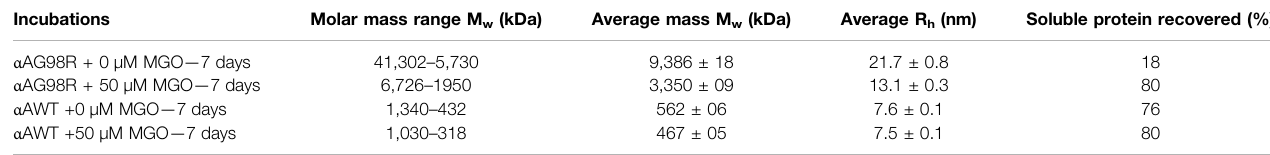
TABLE 2 | Multi-angle light scattering analysis of α AG98R protein treated with MGO for 7 days. Incubations